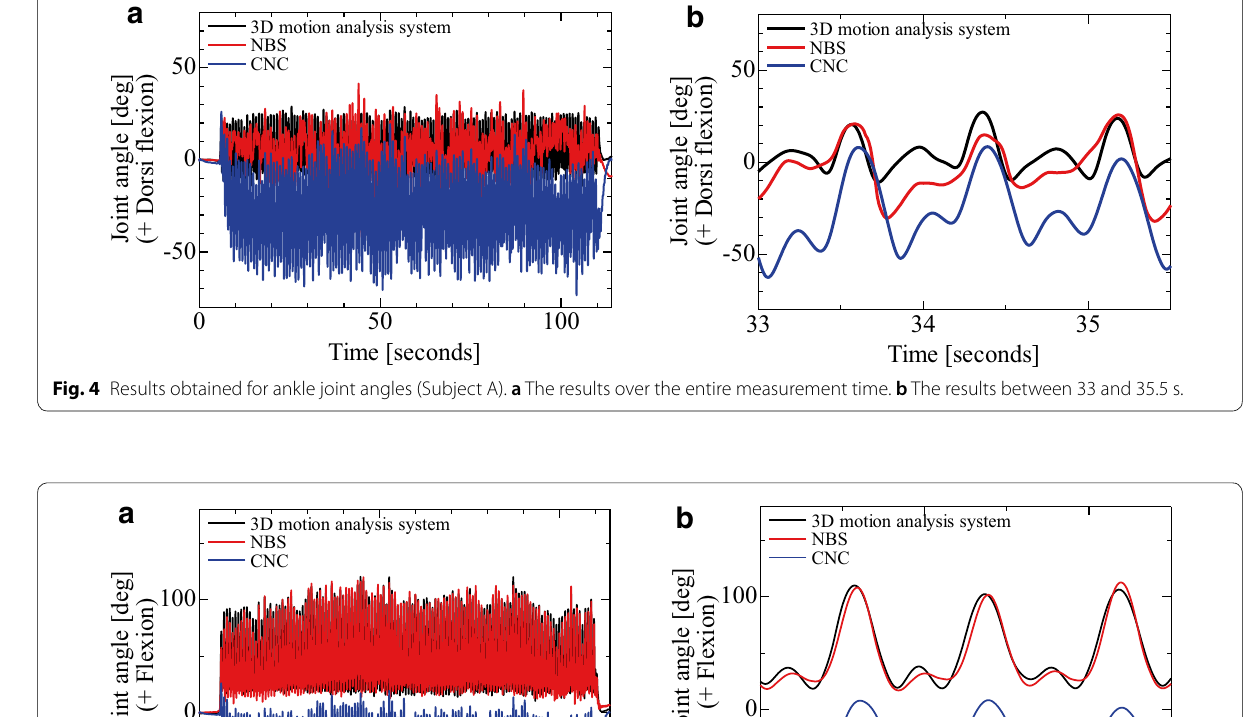
motion analysis system. The estimated ankle joint angle 25° and − using CNC in Fig. 4(a) changes periodically between 70° and 0° over the entire measurement time. Although −